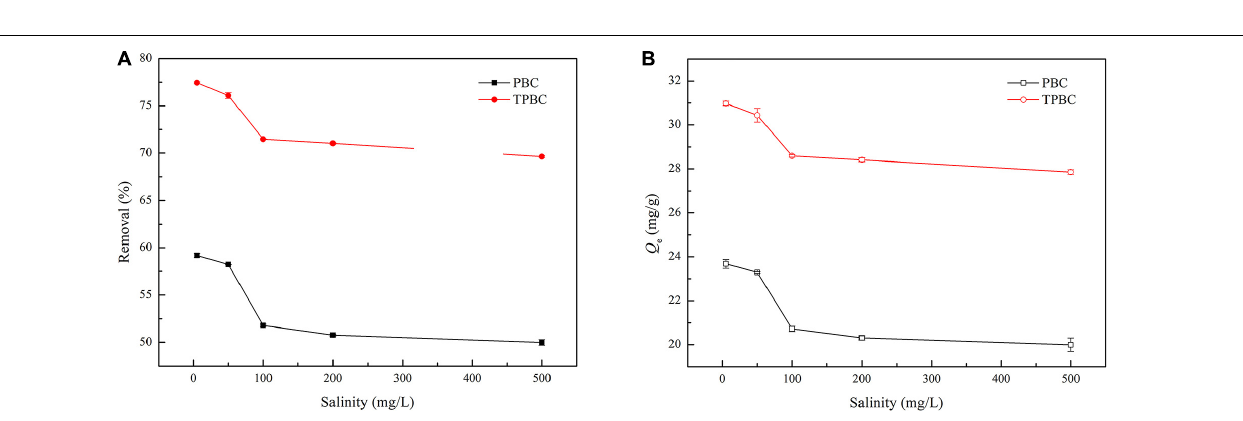
FIGURE 4 | The effect of the salinity on the removal percentage (A) and adsorption capacity (B) .